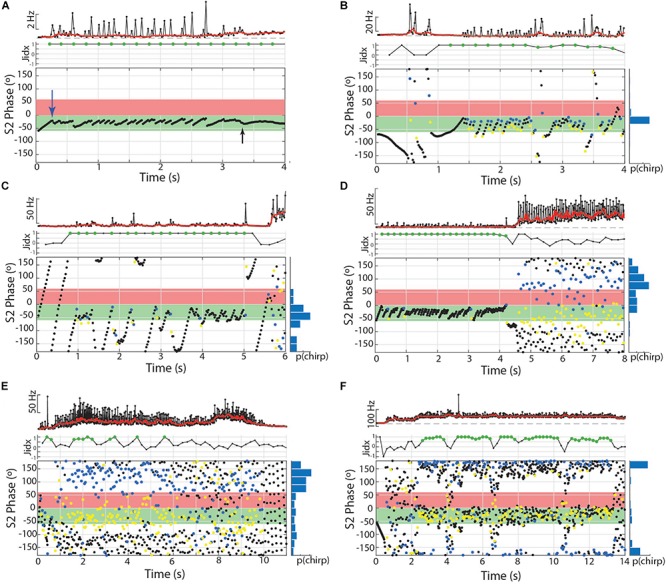
Chirps and chirp-like intervals manipulate phase angle during burst-like chirping and tumultuous rises in Microsternarchus. (A) Subthreshold chirp-like intervals are timed to occur repeatedly at S2 phase angles very late in the S2 cycle (the first one is indicated by the blue arrow) at approximately –5°, equal to 355°. At 2.75 s, the chirp-like intervals are no longer expressed, but the subject switched to a steady matched frequency with a consistent phase of ∼–10° (black arrow). In this and subsequent panels, the jamming index is plotted, with significant positive values shown as green circles. (B) Burst-like chirping (these spikes are well above chirp-threshold of 10% rIPI) produced chirps every 2–6 intervals to maintain jamming avoidance and to fill the critical window of the S2 with EODs. In this and subsequent panels, the normalized chirp probability is shown as a histogram to the right of the phase plot. In all phase plots, the blue circles indicate the start of each chirp and yellow circles mark the location of the next EOD (within the chirp). (C) Another exemplary burst-like chirp episode. In this case, the timing between chirps was matched to a multplie of the S2 frequency, resulting in fewer, more widely spaced chirps, particularly during seconds 1–3. During this period, the S1 avoids being jammed but does not fill the critical phases of the S2 with EODs as occurred with the shorter, more frequent chirps in (B). (D) Jamming by burst-like chirping followed by a tumultuous rise that does not include well matched inter-chirp timings. In the final 4 s of this example, there is no specific asymmetry of jamming interactions, but S1 EODs mostly avoid the critical windows. (E) Example of a tumultuous rise that produced some asymettric jamming but with less specificity than in (D) or (F). (F) Example of a tightly matched tumultuous rise resulting in nearly 12 s of jamming the S2.